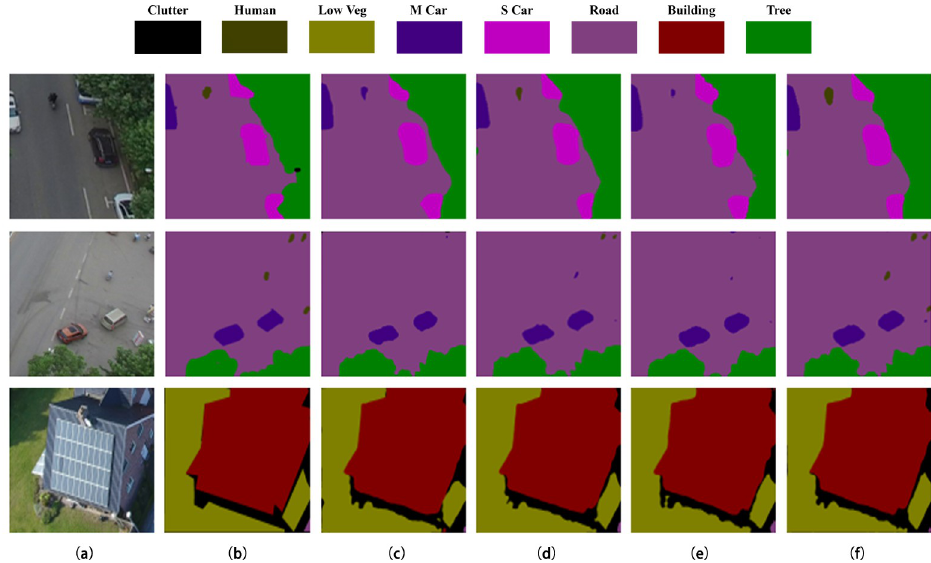
Fig 6. Comparison of segmentation results on UAVid dataset. (a) The original image; (b) The label; (c) The segmentation result of Dv_Xtion; (d) The segmentation result of Dv_Mnetv2; (e) The segmentation result of BiSeNetV2; (f) The segmentation result of EMNet. Reprinted from [16] under a CC BY license, with permission from [UAVid], original copyright [2020].